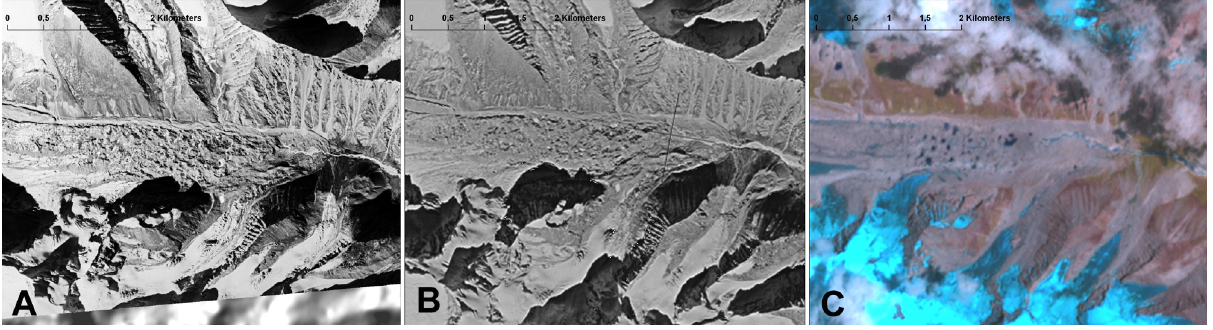
Fig. 4. Terminus of debris-covered Xibu Glacier; Corona, year 1970 (A) , Hexagon, 1976 (B) , Landsat ETM+, 5-4-3-pan, 2009 (C)